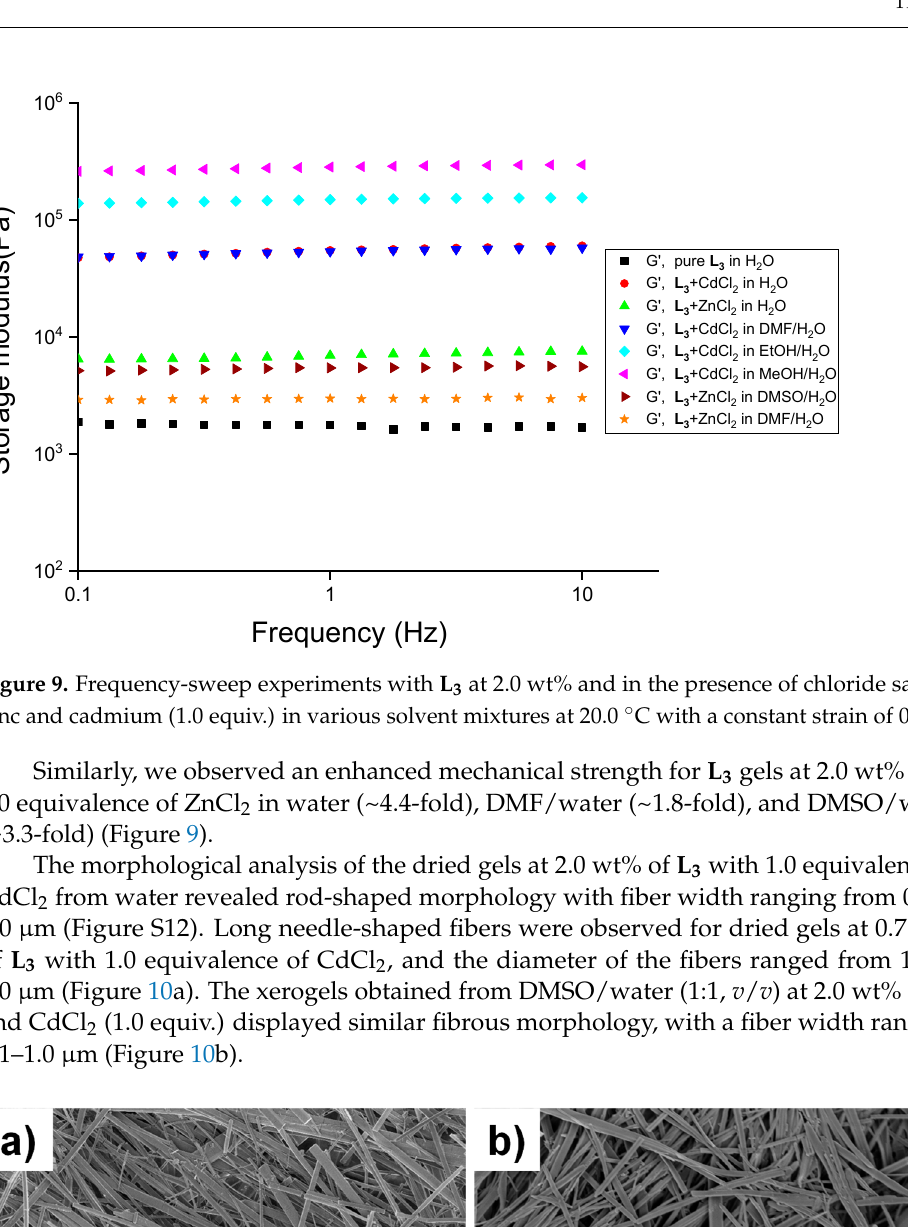
and CdCl 2 (1.0 equiv.) displayed similar fibrous morphology, with a fiber width range of 0.1–1.0 μ m (Figure 10b).